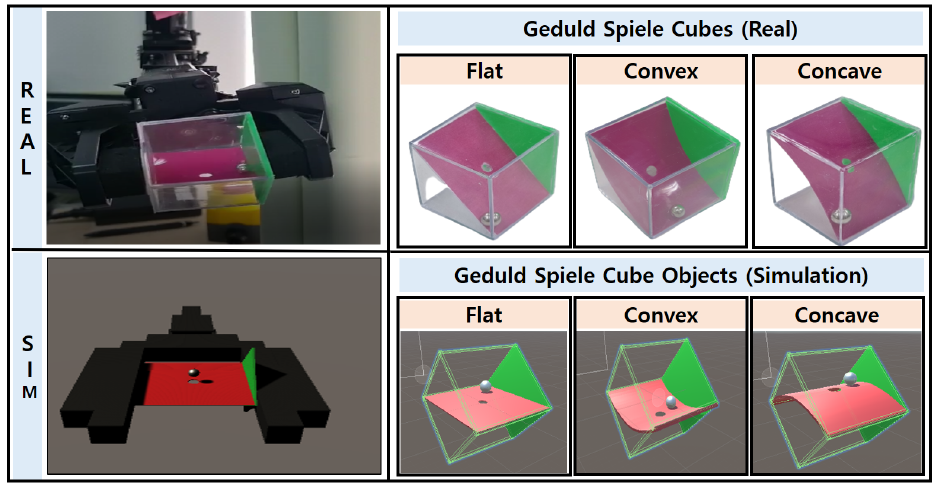
Figure 1. A geduldspiele cube in a robotic gripper and the three different cube types according to the curvature of a plane in the cube: the robotic gripper and the cubes in the real world ( top row ) and the corresponding objects in the simulation ( bottom row